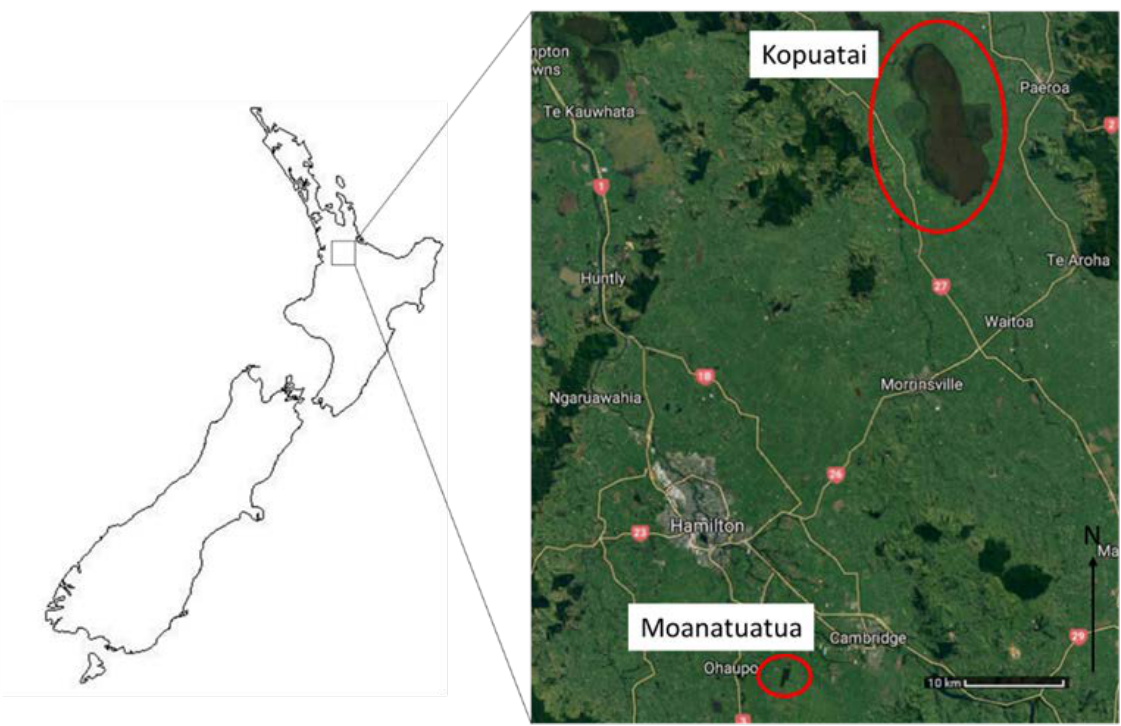
Figure1. Locations of the Kopuatai and Moanatuatua study sites in Waikato Region, Te Ika-a- Māui (North Island), New